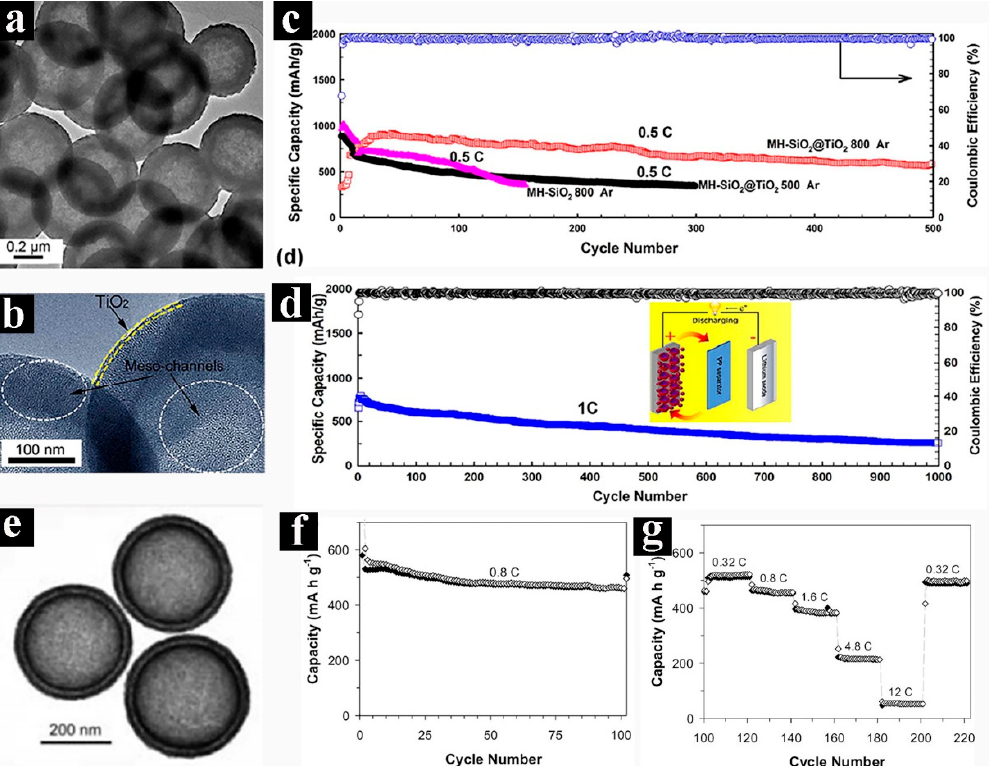
Figure 12. Transmission electron microscopy (TEM) images of hollow and double-shell spheres and their LSBs performance: ( a ) TEM and ( b ) HRTEM images of the SiO 2 @TiO 2 double-shelled hollow spheres (DSHSs), ( c ) cycling performance and Coulombic efficiency (CE) of S composites electrodes at 0.5 C, and ( d ) long cycle stability and CE of S/SiO 2 @TiO 2 composites at high current density of 1 C. ( e ) TEM image, ( f ) cycling performance after 100 cycles at a 0.8 C, and ( g ) rate capability of the SnO 2 DSHSs. Pictures ( a ), ( b ), ( c ), and ( d ) were reprinted with permission from Reference [184]. Copyright Elsevier, 2017. Pictures ( e ), ( f ), and ( g ) were reprinted with permission from Reference [71]. Copyright Wiley, 2009.